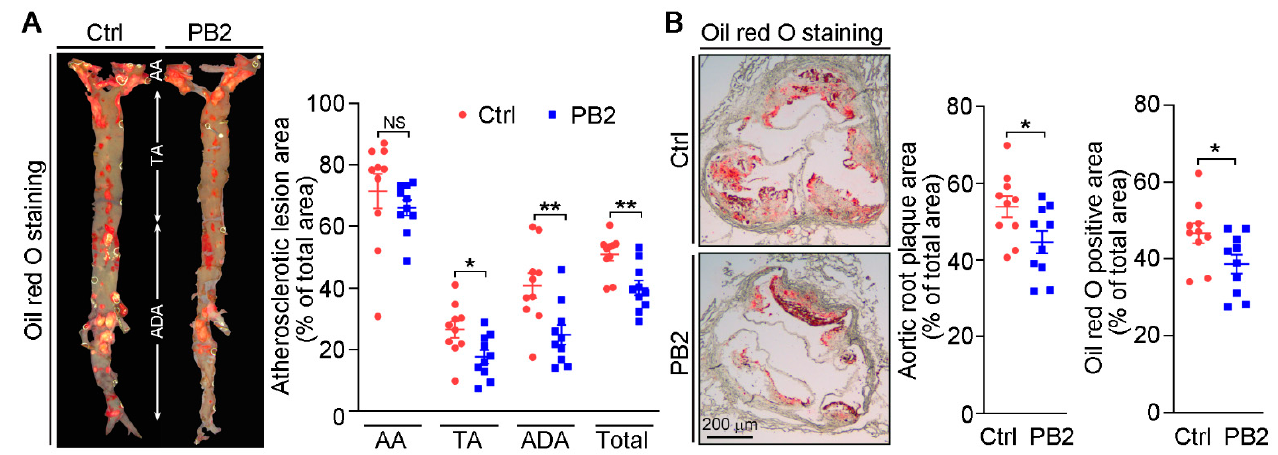
Figure 1. Procyanidin B2 inhibits atherosclerosis in apoE − / − mice. ApoE − / − mice in two groups (10/group) were fed HFD and HFD containing PB2 (80 mg/kg body weight) for 18 weeks. At the end of experiment, aortas and blood samples were collected for the following assays. ( A ) Lesions in en face aortas were determined by oil red O staining, and lesion areas in en face aorta and different segments of aortas were quantified as percentages of the corresponding whole area. AA: aortic arch; TA: thoracic aorta; ADA: abdominal aorta; Total: whole aorta. * p < 0.05, ** p < 0.01 (10 mice per group were used, and at least three samples from each mouse were taken as technical replicates). ( B ) Aortic root sections were used to determine sinus lesion areas by oil red O staining, and the quantitative results of lesions are presented. * p < 0.05 (10 mice per group were used, and at least three samples from each mouse were used as technical replicates). Table 1. Effect of PB2 on the activity of aminotransferase and ALP, as well as lipid profiles, in apoE − / −